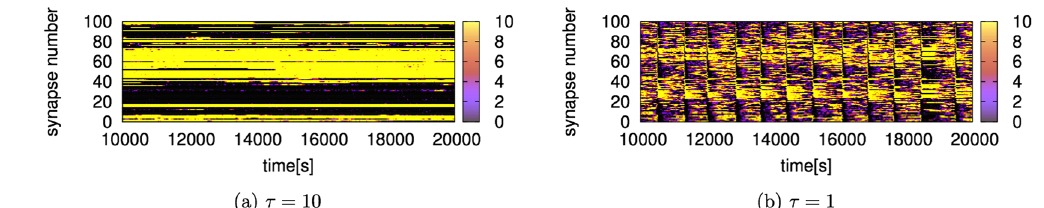
Figure 3. Temporal changes in the synaptic weights in all synapses from an excitatory neuron. The horizontal axis is time [s]. The vertical axis is the synapse index. The colors show the strength of synaptic weights indicated by color bars. The synaptic weights are almost constant and are separated into maximum and minimum values when τ = 10. On the other hand, the synaptic weights change periodically and some synapses have intermediate values when τ =